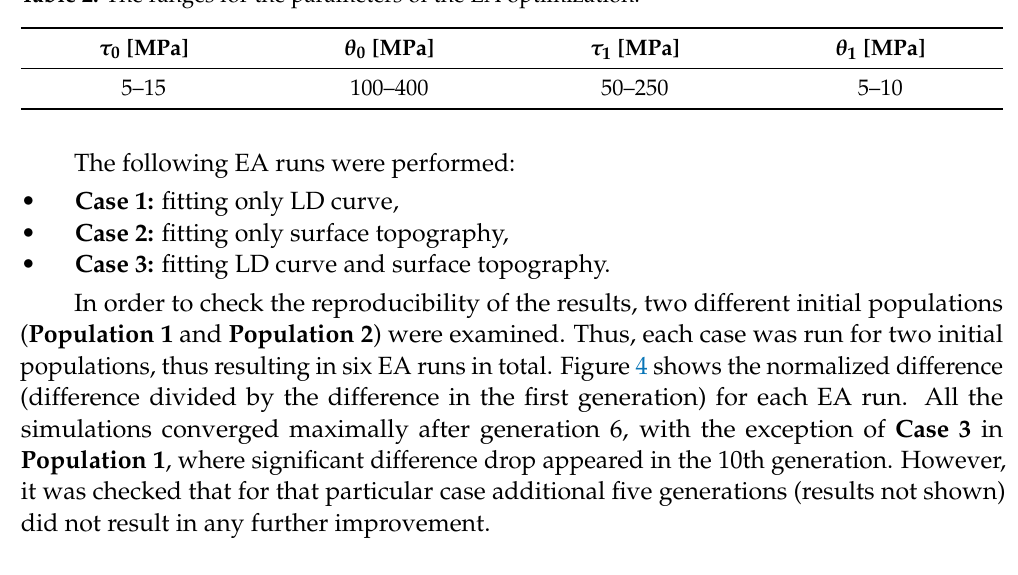
Table 2. The ranges for the parameters of the EA